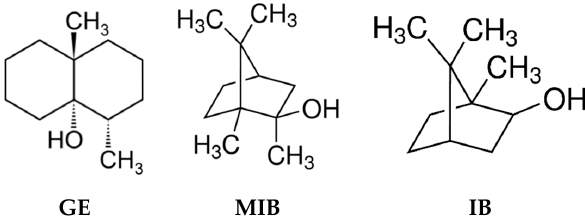
Figure 1. Chemical structures of taste-and-odor compounds: GE: geosmin, MIB: methyl-isoborneol, IB: isoborneol.